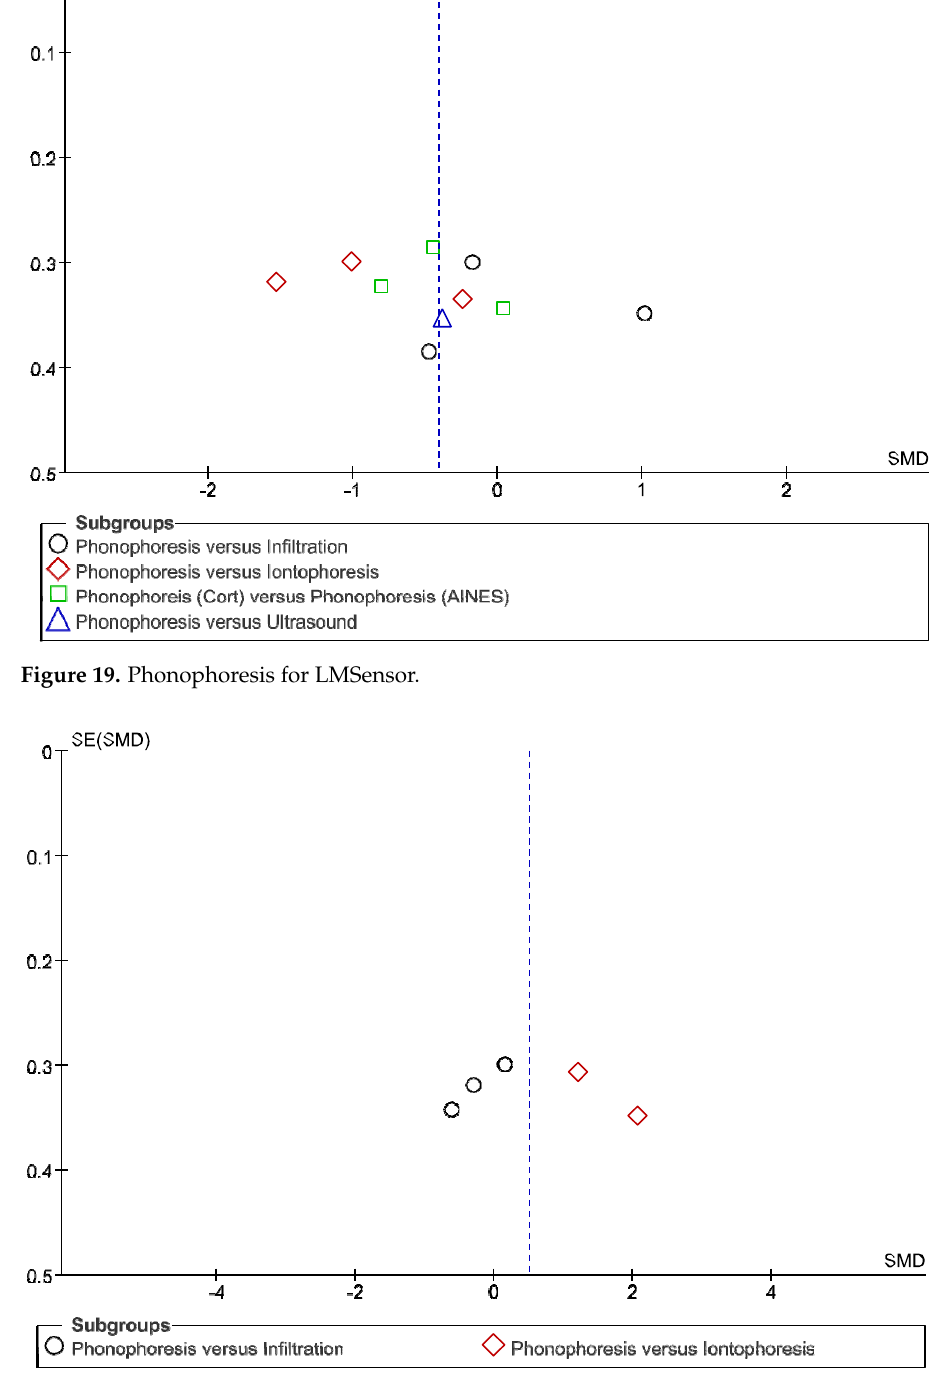
Figure 20. Phonophoresis for Grip strength.